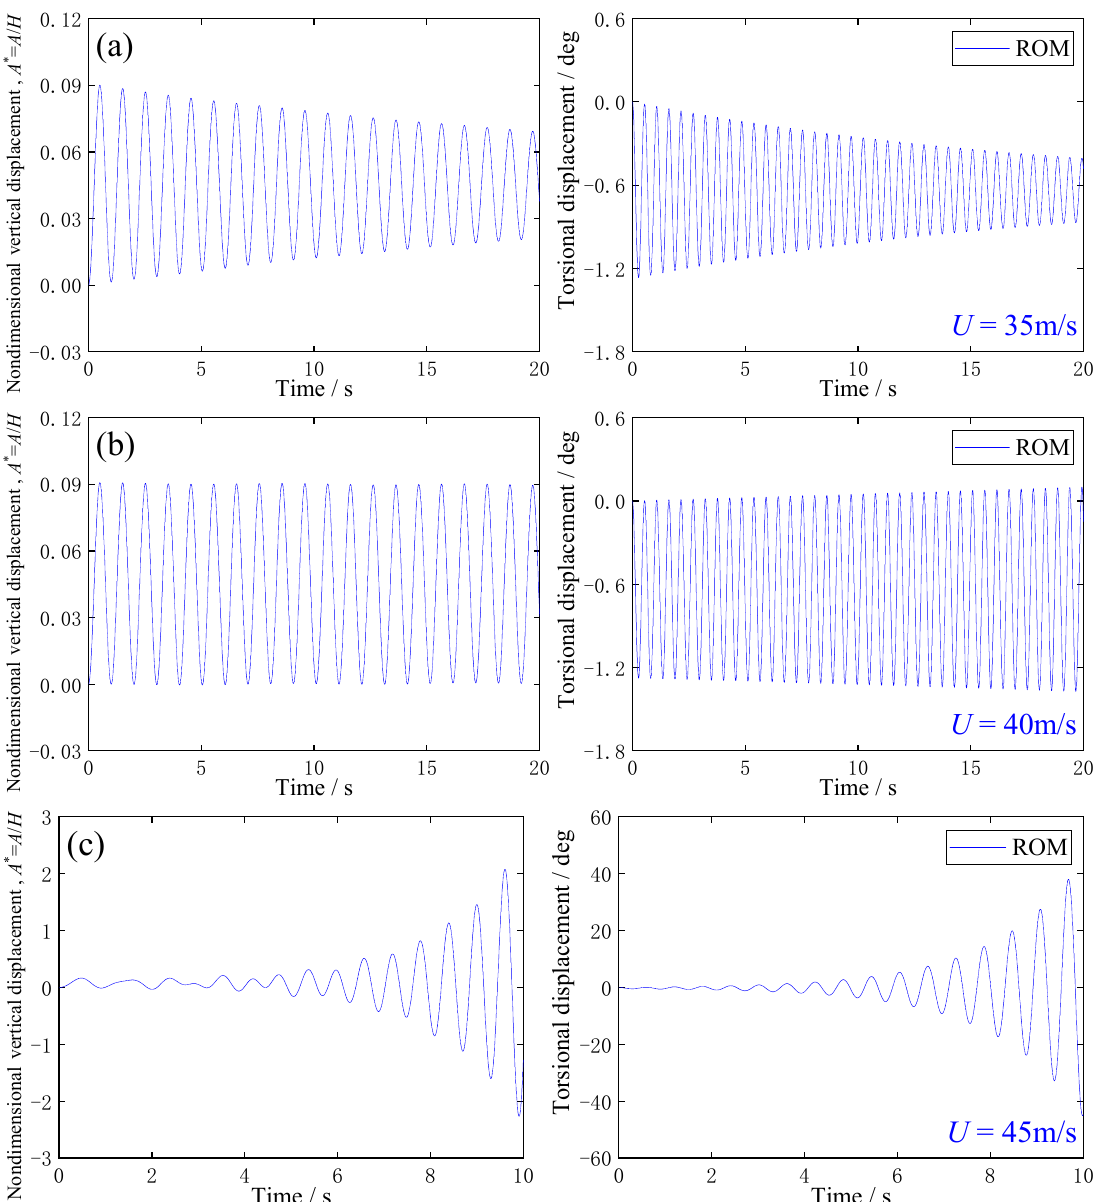
Figure 10. Vertical and torsional displacements of the main deck section of GBEB, based on the ROM method under incoming wind speeds of ( a ) 35 m/s, ( b ) 40 m/s, and ( c ) 45 m/s for the prototype bridge, respectively.